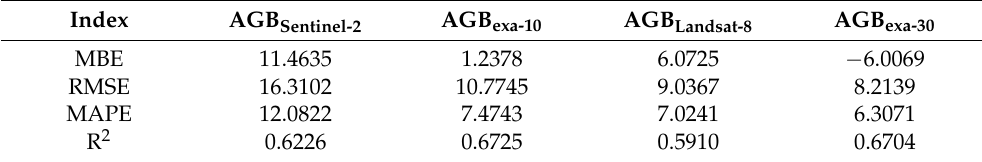
Table 7. Accuracy of the scale error corrected AGB at various spatial